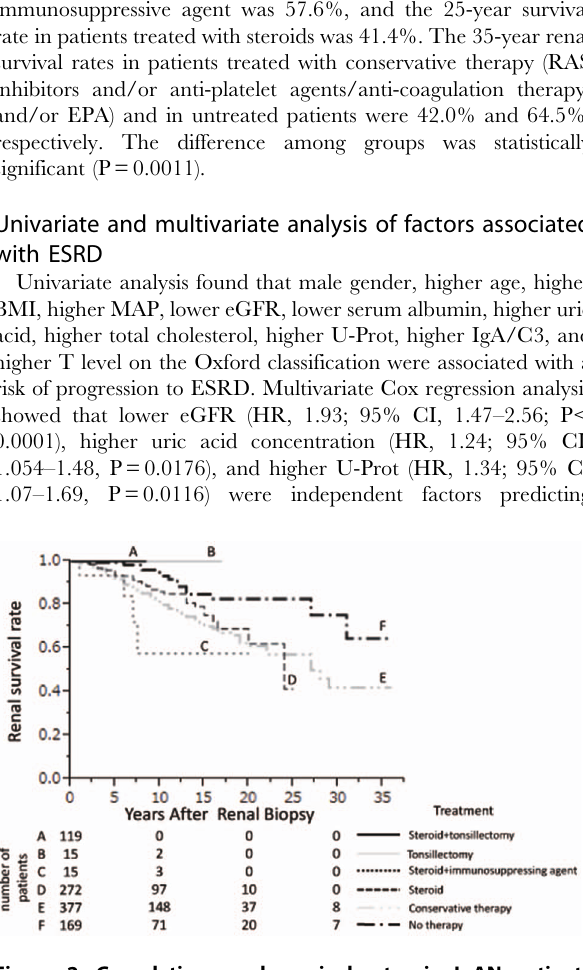
Figure 2. Cumulative renal survival rates in IgAN patients categorized by initial treatment.